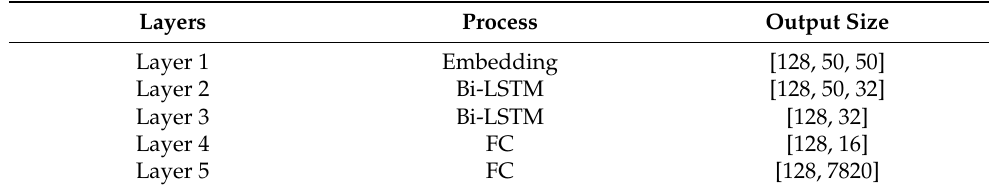
Table 1. In the model setting, the input length is set to 50, the output length is 7820, and the batch is set to 128.